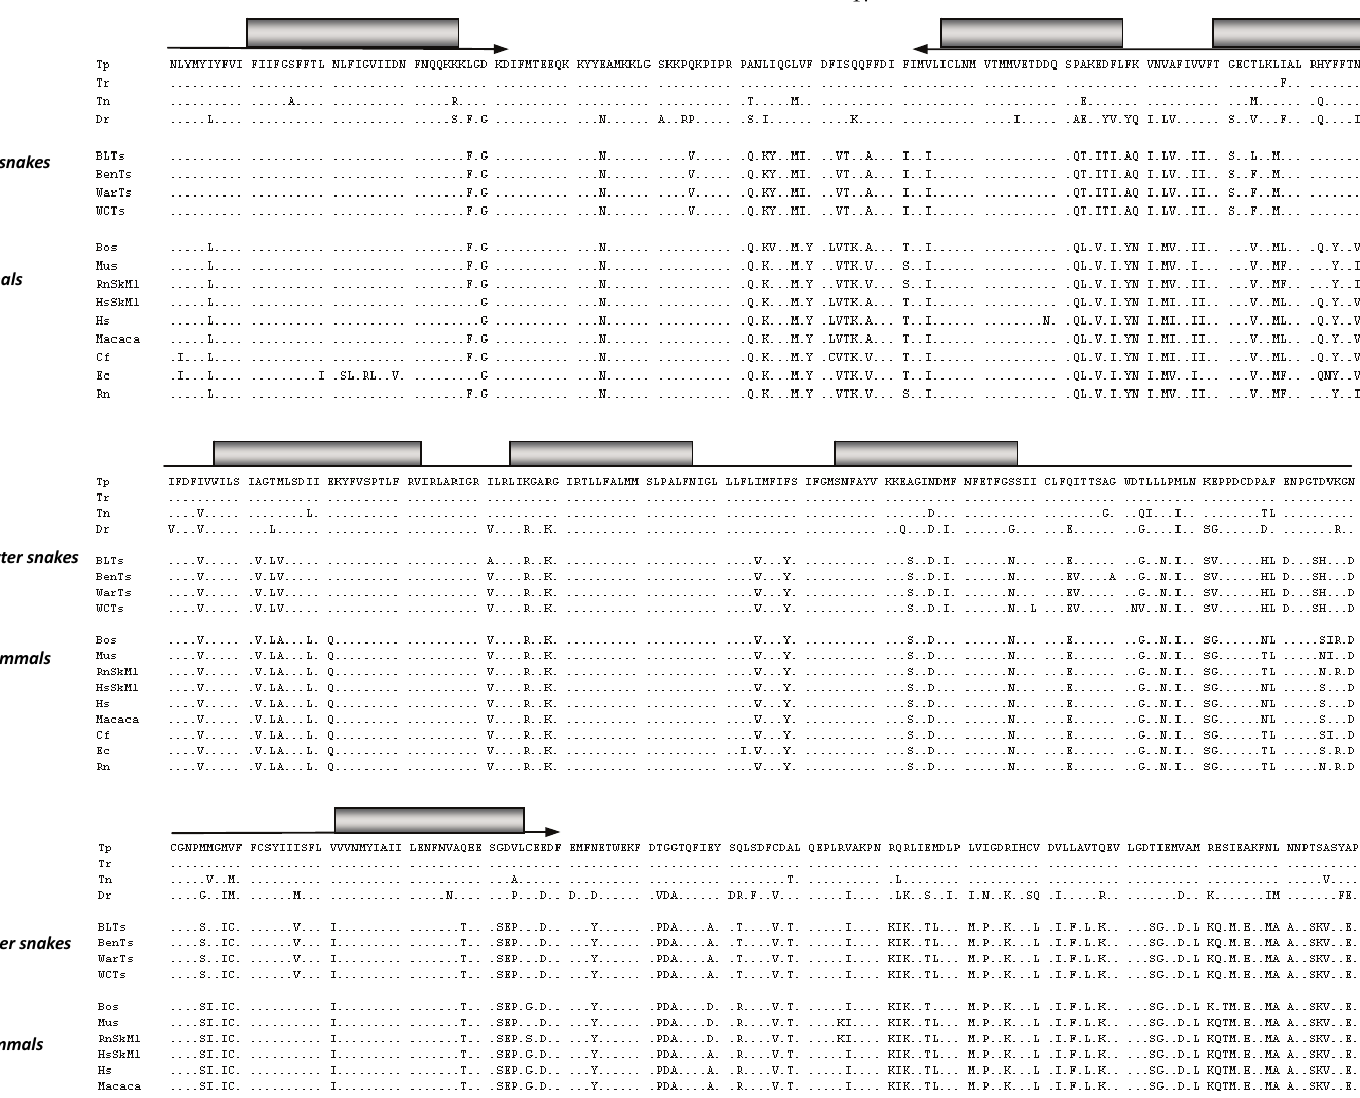
Figure S1 Alignment of the complete sequence of Na